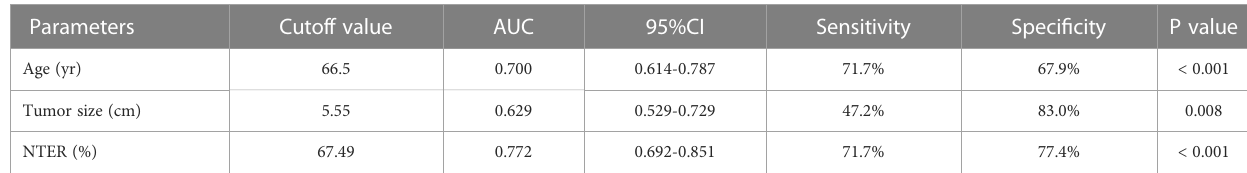
TABLE 3 ROC curve analysis results for classi fi cation of the